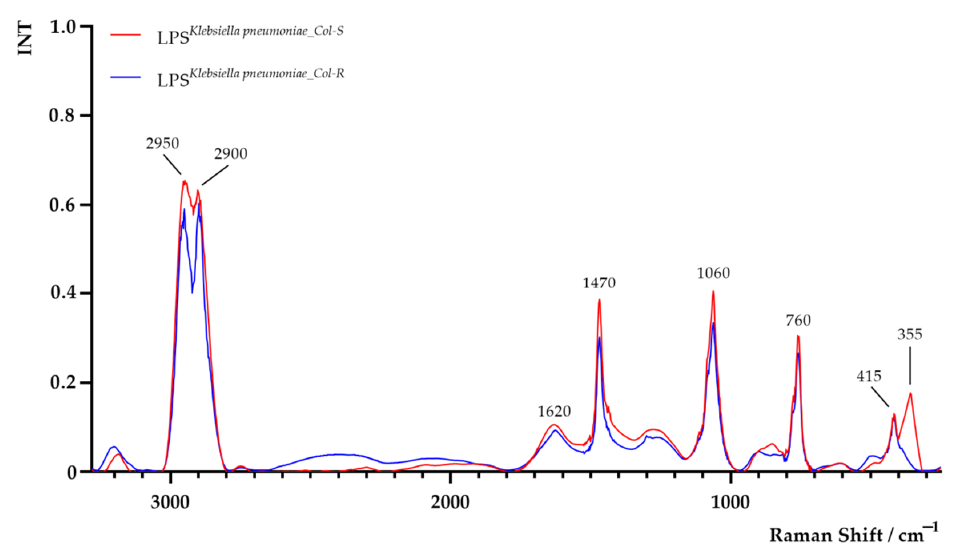
Figure 5. Raman spectra of lipopolysaccharide (LPS) extracted from colistin-susceptible (LPS K. pneumoniae _ Col-S ) and laboratory-induced high-level colistin-resistant (LPS K. pneumoniae _ Col-R ) Klebsiella pneumoniae strains.